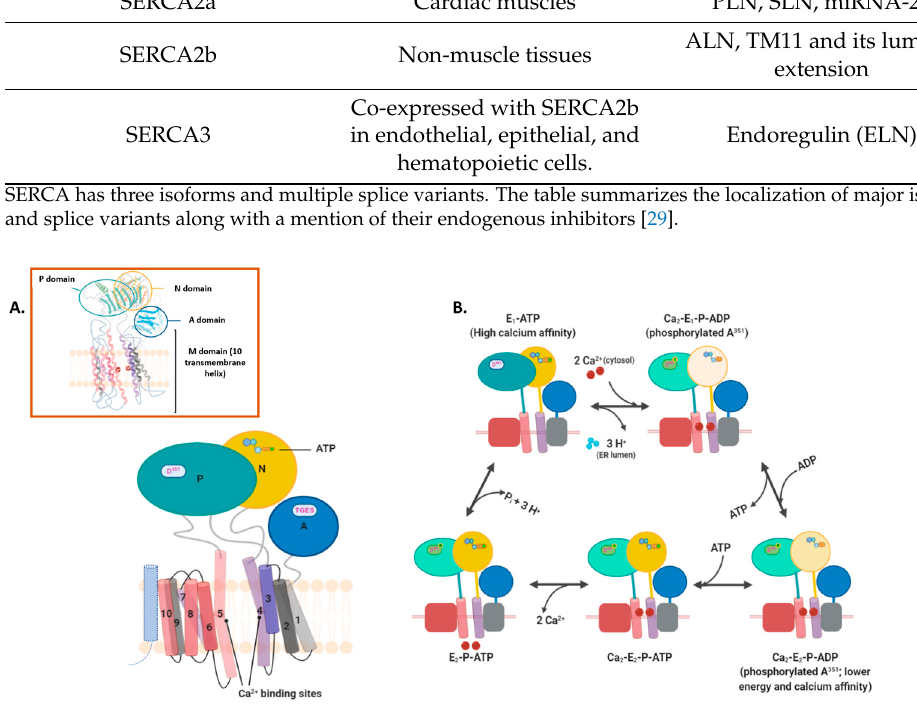
Figure 3. Sarcoplasmic endoplasmic Ca 2+ -ATPase structure and mechanism of Ca 2+ ion transport. ( A ) SERCA pump structure is comprised of Actuator or A domain (for dephosphorylation), transmem- brane or M domain (10 helices and two Ca 2+ ion binding sites between helices 4 and 5), Nucleotide or N domain (source of phosphorylation), and Phosphorylation or P domain (consists of the site of phosphorylation; aspartate 351 residue) [26]. Picture in the inset is a simplified representation of SERCA crystal structure; ( B ) Numerous steps are involved in the transport of Ca 2+ via SERCA across the endoplasmic reticulum membrane [28–31]. As per the above model, the pump cycle be- gins with SERCA having a high affinity to Ca 2+ in its physiologically predominant E1-ATP state. After cytosolic Ca 2+ ions bind to SERCA, the pump transitions into Ca2-E1-P-ADP state utilizing the energy from the transfer of ATP γ -phosphate in the N domain to D351 amino acid residue in P domain. Transport of Ca 2+ ions to the ER lumen parallels the shift of pump from its high-energy intermediate conformation to the low energy E2-ATP state (with less affinity to Ca 2+ ; not shown) triggered by replacement of ADP with ATP. Ca 2+ ions are then exchanged in the lumen with 2–3 protons compensating for the loss of positive charge. Followed by dephosphorylation at D351. In a Ca 2+ -free resting stage, the γ -phosphate of ATP in N-domain is masked from phosphorylation site (P domain Asp 351 ) as well as the dephosphorylation site (A-domain TGES sequence) [25,32]. When